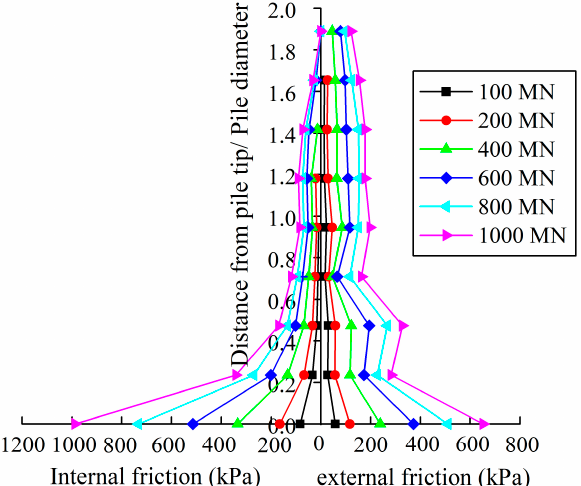
Figure 14. Comparison of internal and external skin friction under loading.